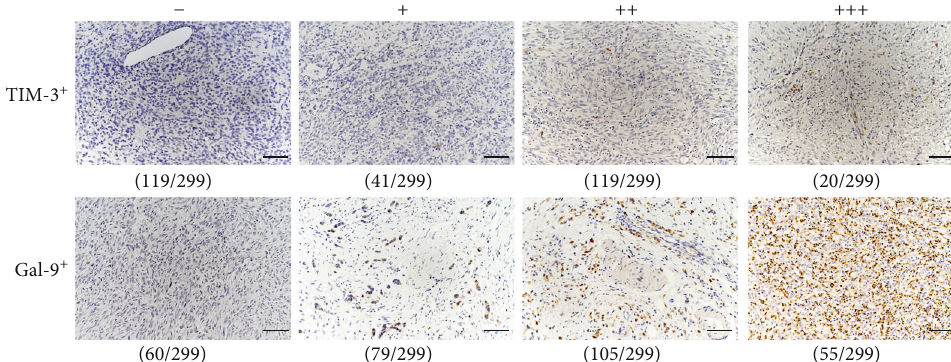
Figure 1: Representative images of individual expression levels of TIM-3 and Gal-9 are shown with their corresponding frequencies in GIST cohorts. The symbol in the top indicates the intensity scores of indicated immune markers. The number in the bottom of every picture indicates the corresponding amounts of the score (original magni fi cation: × 200; Scale bars, 200 μ